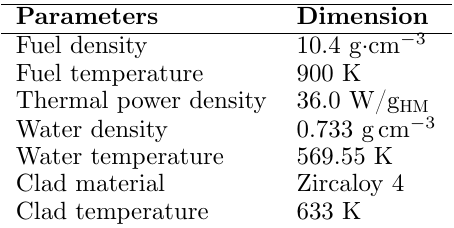
Table 1. Assembly geometrical data [9]. Table 2. Other assembly